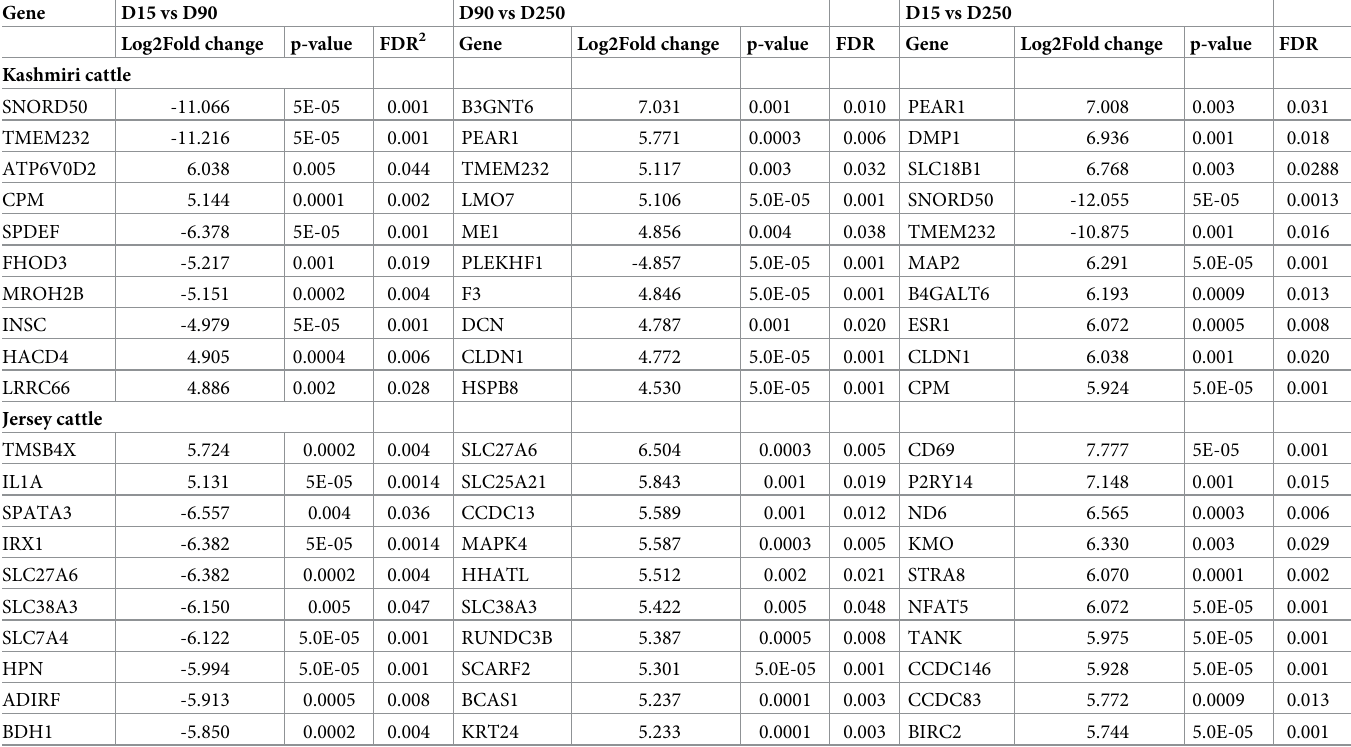
Table 3. Top 10 differentially expressed genes in mammary epithelial cells with highest fold changes between lactation stages in Kashmiri and Jersey cattle 1 .